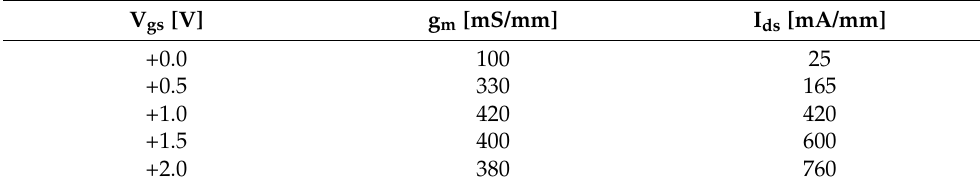
Table 1. Transconductance (g m ) and drain-source current (I ds ) of an AlGaN/GaN-based enhance- ment mode HFET under sole application of five different constant electrical gate voltages (i.e., V gs,el = +0.0 V, +0.5 V, +1.0 V, +1.5 V, and +2.0 V).